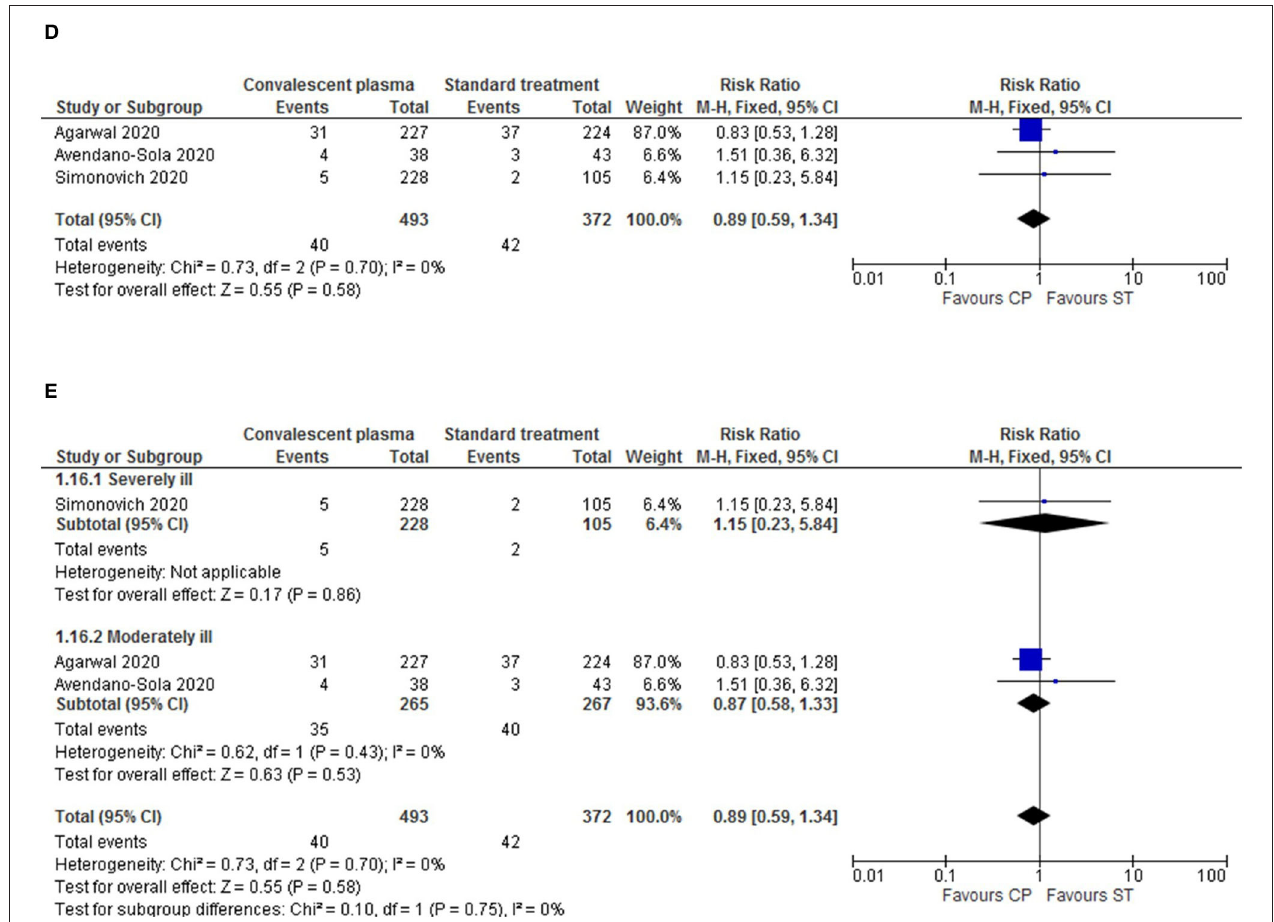
FIGURE 5 | Forest plots assessing the need for invasive (A–C) and non-invasive (D,E) mechanical ventilation in CP intervention and standard treatment. (A) Concerning the need of invasive mechanical ventilation both groups showed no difference although a tendency favoring the CP treatment can be observed. The results also indicate moderate heterogeneity levels; therefore we conducted a sub-analysis. (B) Sub-analysis by disease severity (miscellaneous of critical and severe patients, and moderately ill patients). (C) Sub-analysis by study design (RCT vs. CNRT). (D) The analysis regarding the need of non-invasive mechanical ventilation showed that both groups presented no significant difference, although patients in the CP group had lower necessity of supplemental oxygen. The heterogeneity levels were null, thus a sensibility analysis by disease severity was performed (E) . Different sizes of data markers correspond to the relative weight assigned in the pooled analysis. Diamond marker indicates the overall